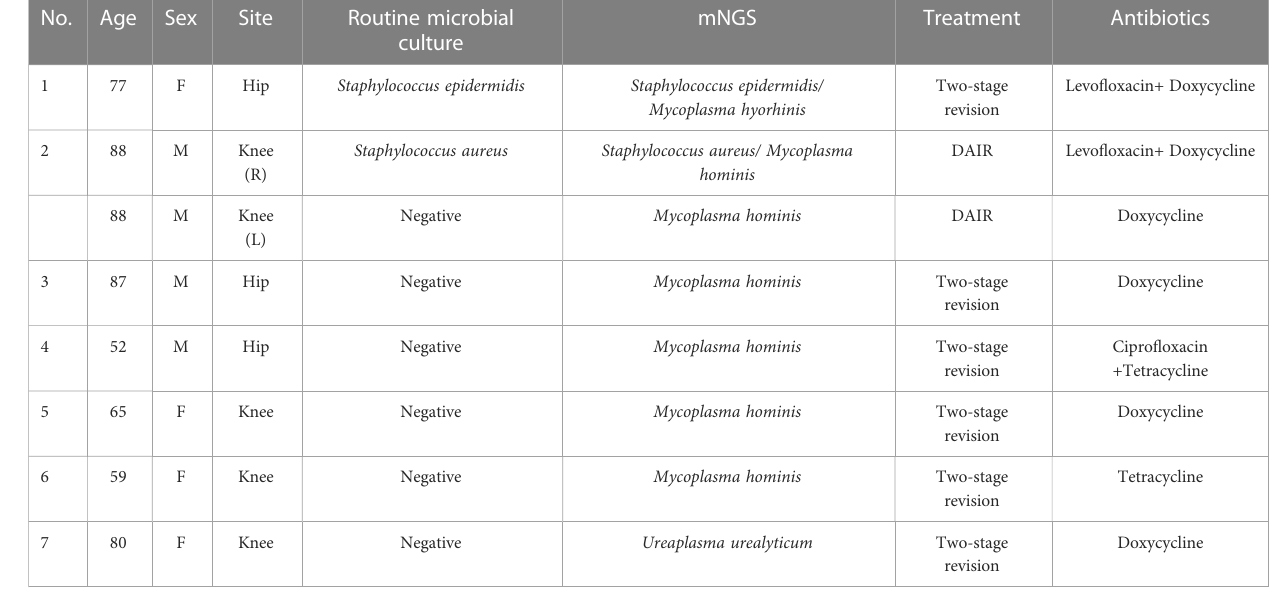
TABLE 1 Periprosthetic joint infection cases caused by Mycoplasma .